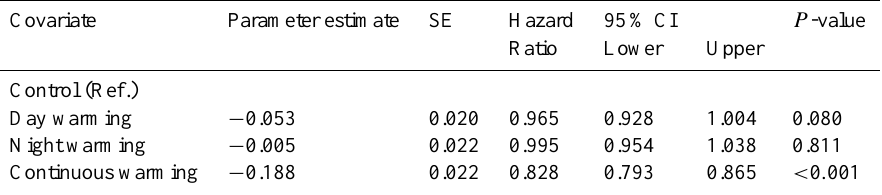
Table 3. Analyses of different warming treatments (day warming, night warming and continuous warming) on the root hazard ratio by the Cox proportional hazards regression. Hazard ratios for categorical covariates are the risk of death relative to a reference level, given for each covariate in the left-hand column. A negative parameter indicates that increases in the covariate would result in decreases in the risk of mortality, and the opposite trend reflects positive parameter values. The values for 95% confidence intervals are upper and lower limits and are not symmetrical about the hazard ratio. P < 0.05 is considered to be